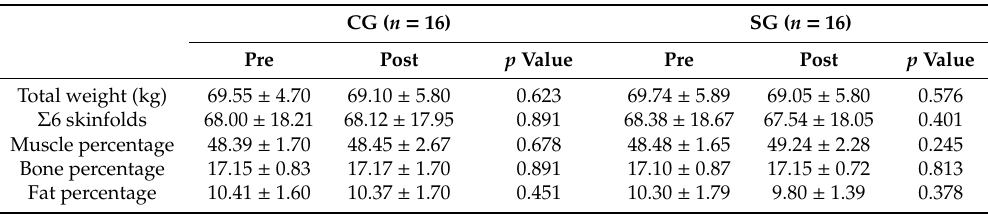
Table 2. Anthropometric values.